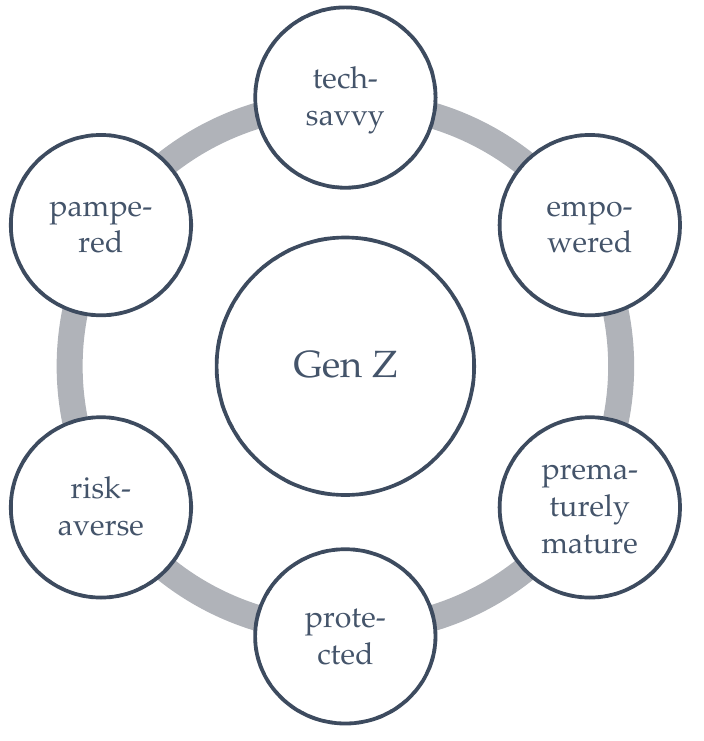
Figure 1. Gen Z Figure 1. Gen Z characteristics.